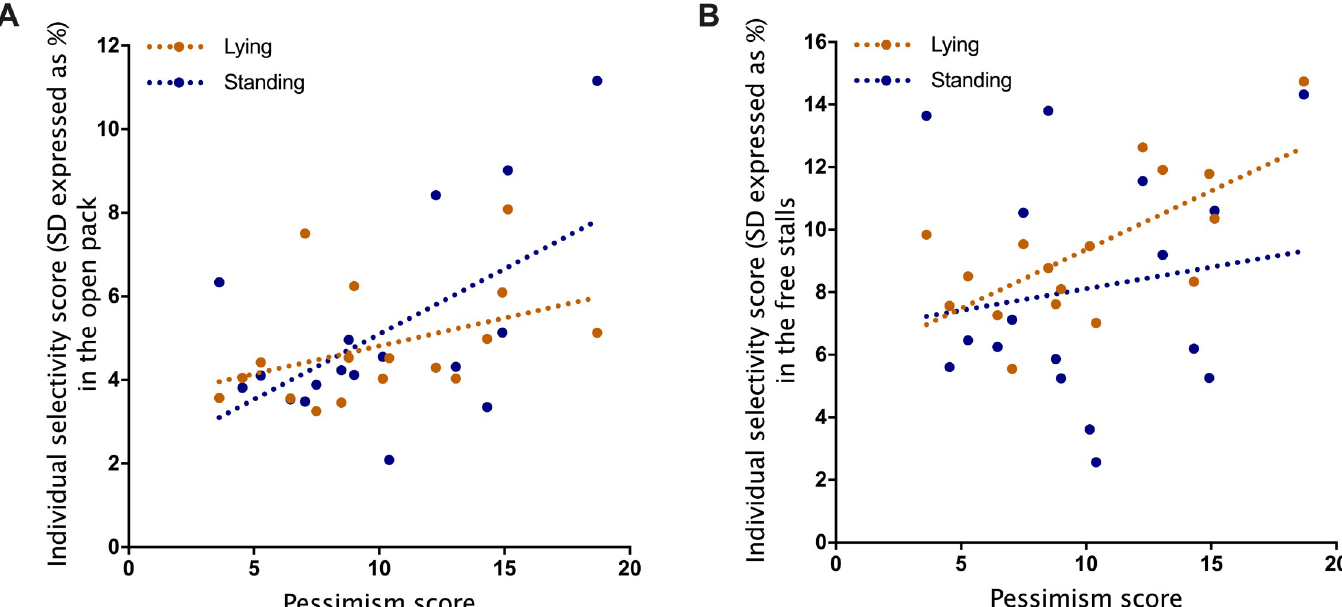
Fig 3. Relationship between pessimism and individual selectivity scores calculated when animals were in the open pack (A) and in the free stalls (B). Selectivity scores and linear regressions are reported for when animals were either lying (orange dots) or standing (blue dots) (n = 18). Selectivity scores were calculated by reporting the number of interactions the individual had with each pair to its total number of interactions. We then calculated the standard deviation of these selectivity scores to get a single selectivity score per individual per observation area (open pack or free stalls) and per behavior (i.e. lying or